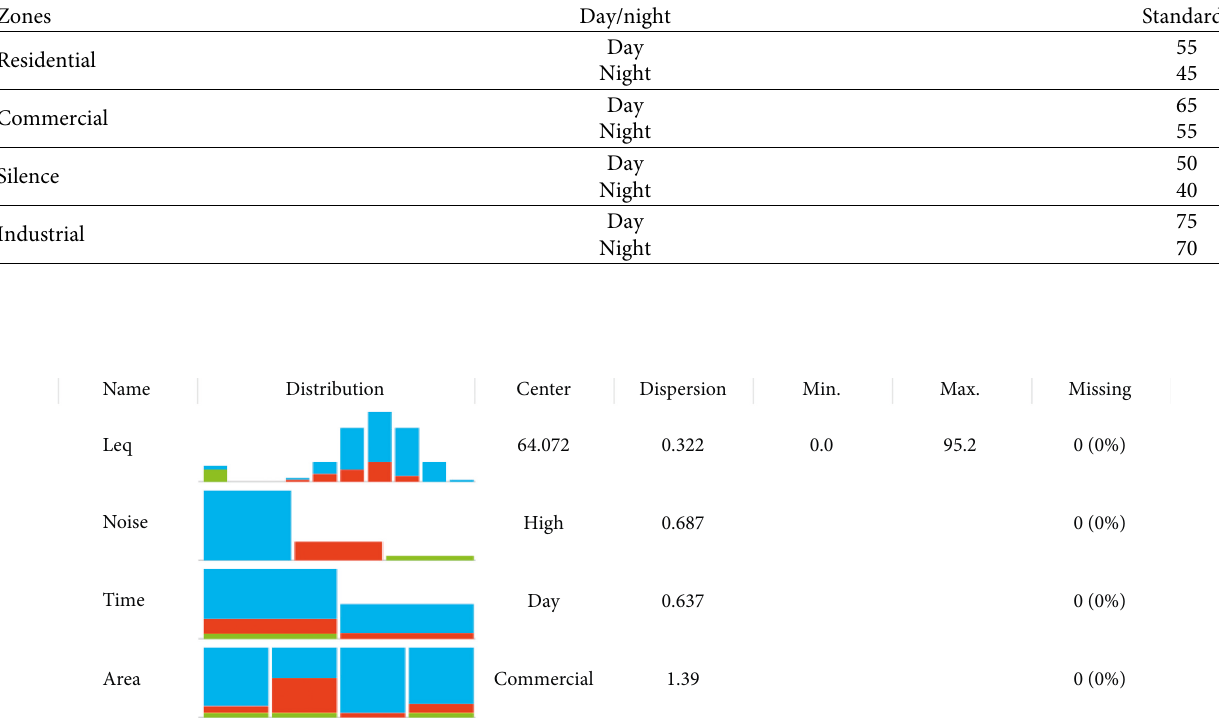
Figure 3: Histogram generated using Orange tool for different dataset features with respect to noise feature (blue: high, red: low, green: